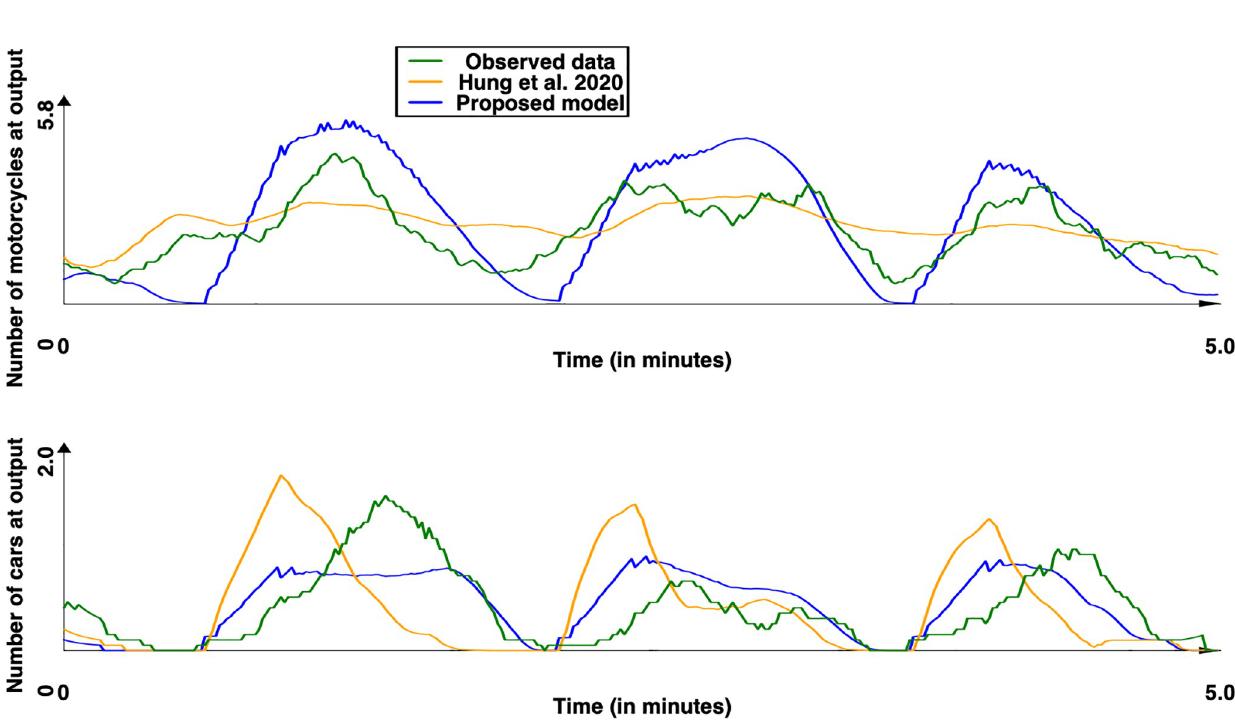
Fig 10. Observed and simulated results (with [44] and our models) for the Tay Son site. Motorcycle and car counts—mean of the simulation (time series were smoothed out using moving average with a window size of 10s.